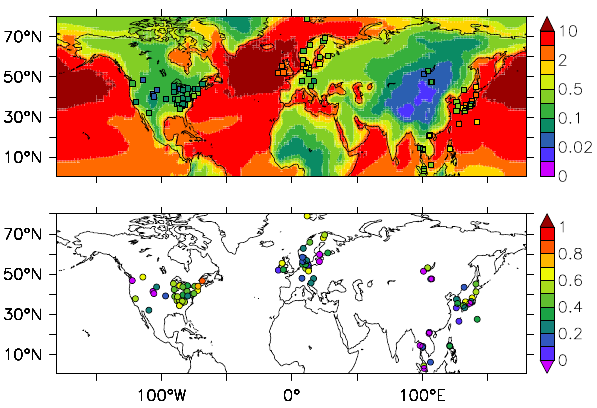
Fig. 11. As Fig. 5 but for Na + .